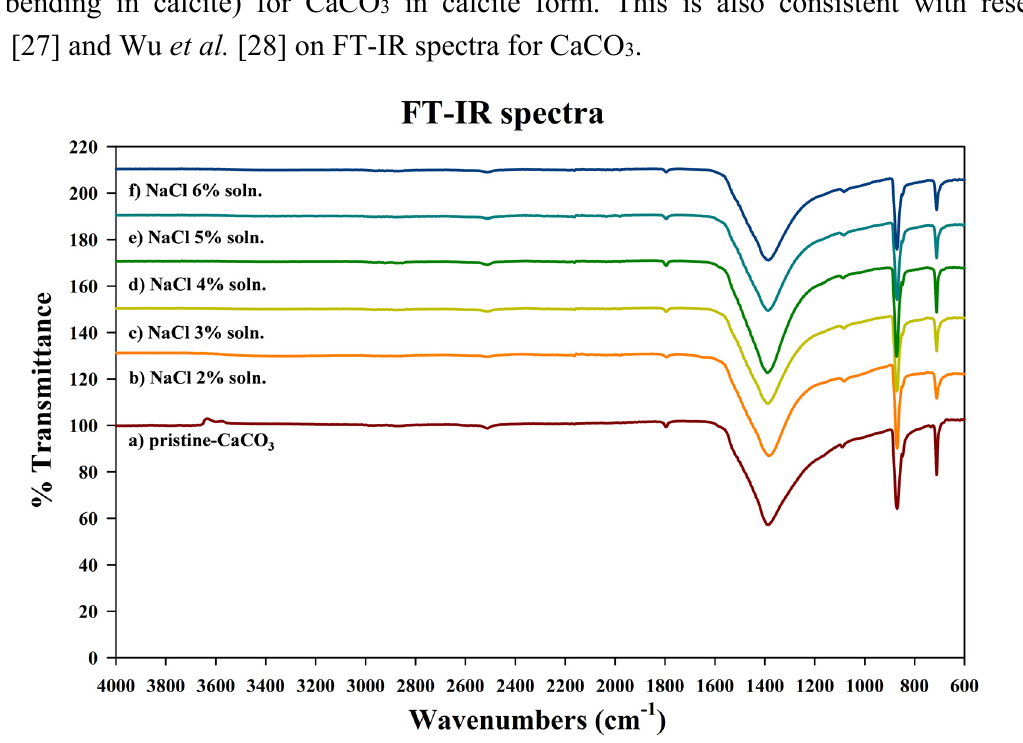
Figure 4. FT-IR spectrum of ( a ) pristine-CaCO 3 ; ( b ) NaCl 2% soln; ( c ) NaCl 3% soln; ( d ) NaCl 4% soln; ( e ) NaCl 5% soln; ( f ) NaCl 6%